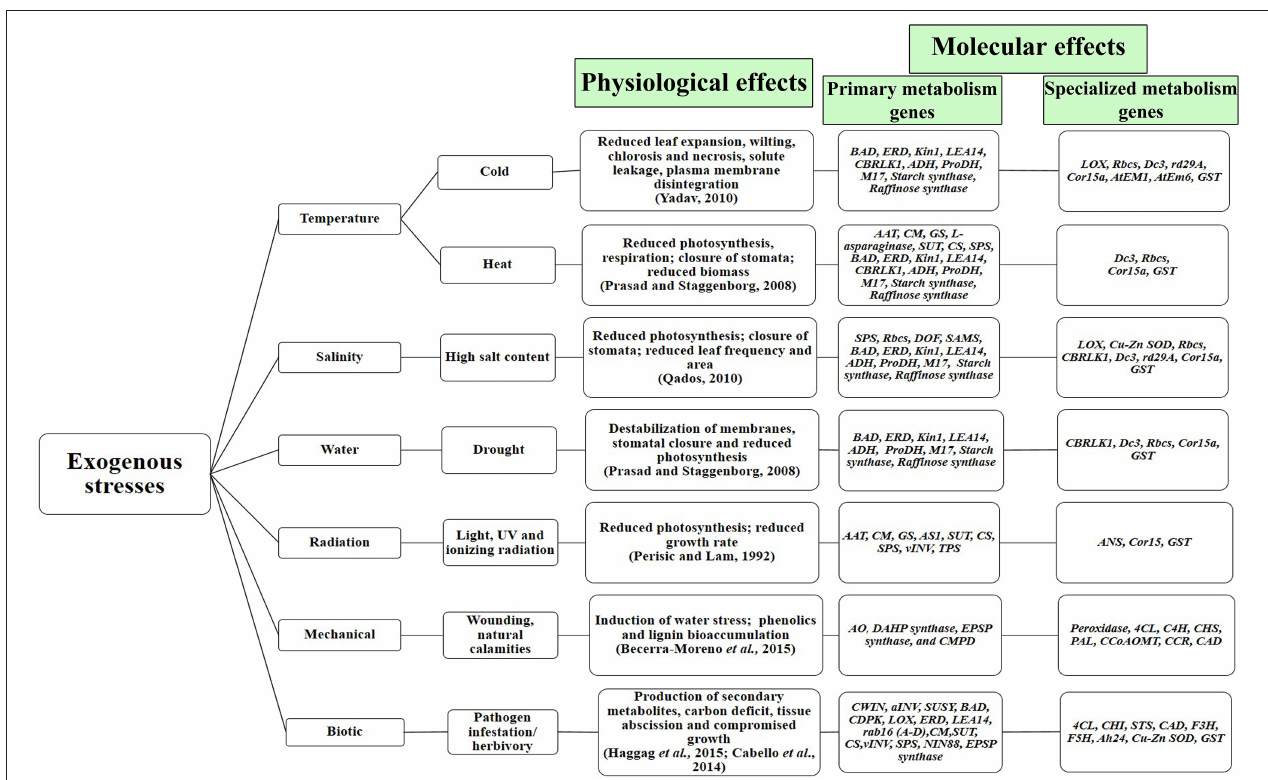
FIGURE 2 | Physiological and molecular effects of phyto-stress. Temperature, salinity and drought stress have similar physiological and molecular footprints. The depicted primary and specialized metabolism genes show synchronized upregulation under abiotic and biotic stress (Full forms, the detailed list of stress-regulated genes and their references have been given in Table 1